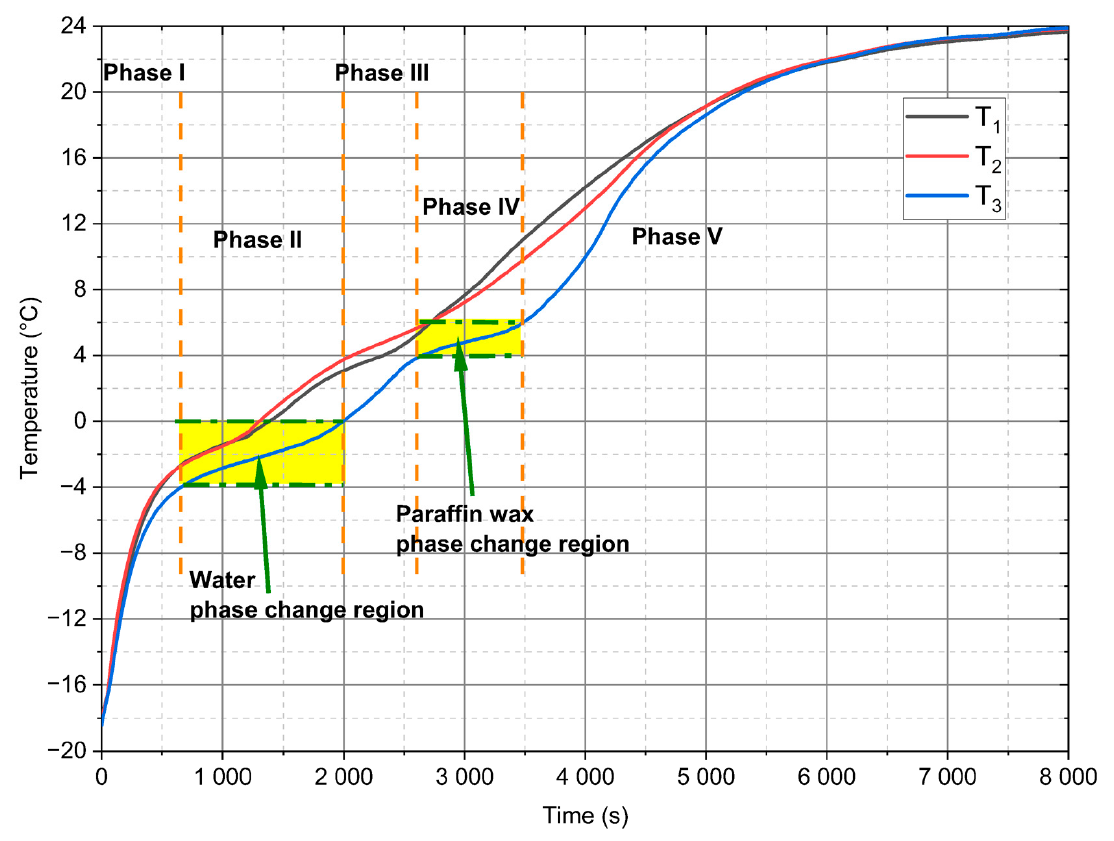
Figure 10. Measured temperatures evolution for d = 28 mm PCM module and 0.92 m/s value of the